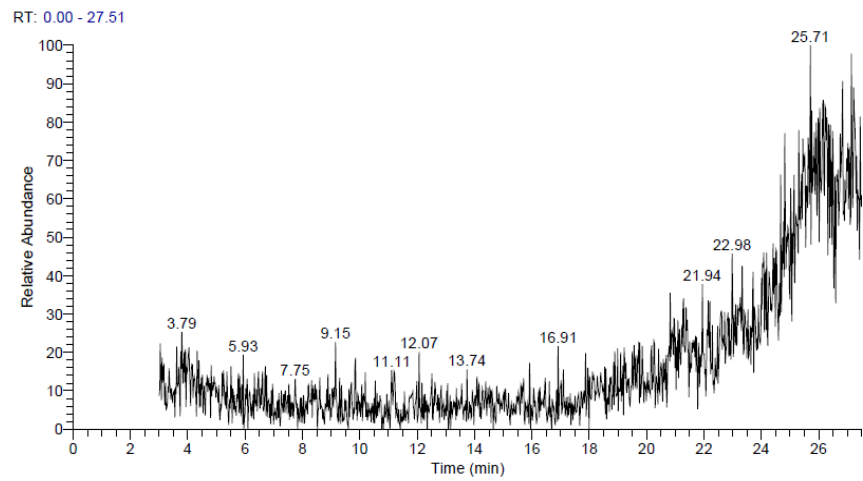
Figure 5. GC-MS chromatogram of alcoholic extract of Rhizome of Euphorbia wallichii .